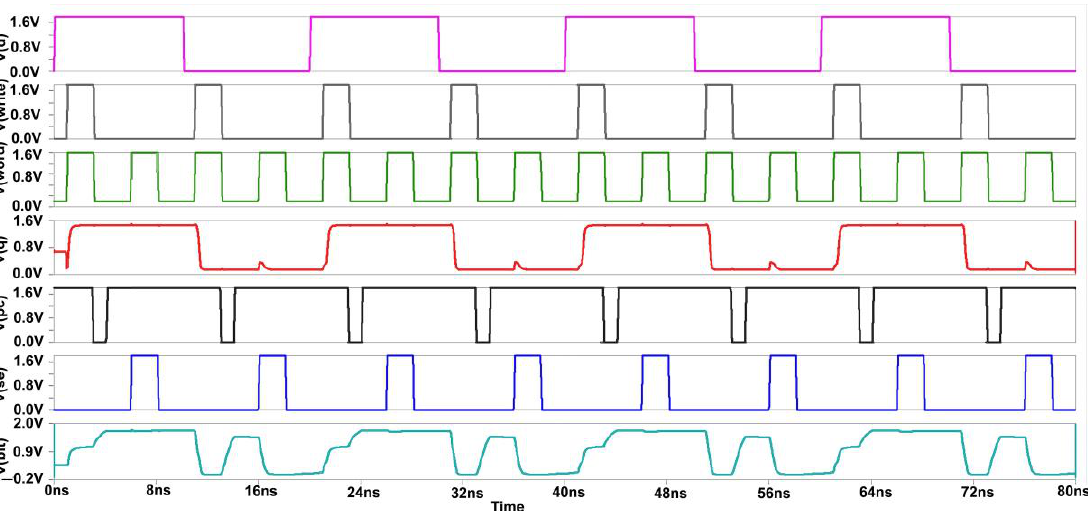
Figure 7. Output waveform of Basic Latch Sense Amplifier.